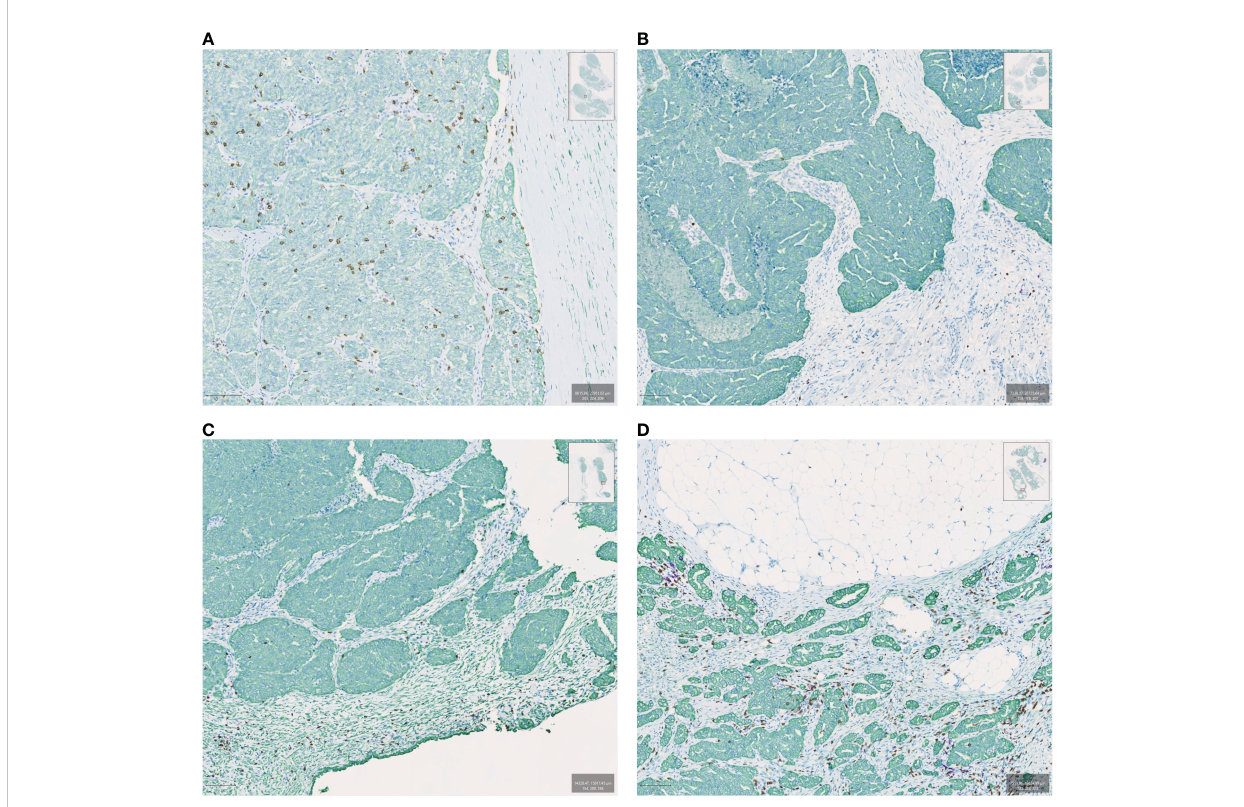
FIGURE 1 Examples of immune spatial phenotypes in ovarian cancer samples evaluated by multiplexed immunohistochemistry. Samples are stained with CK (green), CD8 (brown), and CD20 (purple). (A) Immune in fl amed, (B) Immune desert, (C) Immune excluded with CD8 lymphocytes peripheral to the tumor bed, (D) Immune excluded with CD8 lymphocytes in the tumor bed but con fi ned to the